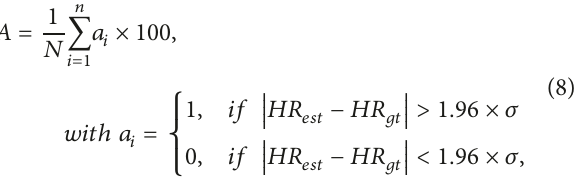
Table 2: Comparison of the performance of related methods with the MAHNOB-HCI dataset (best performance in